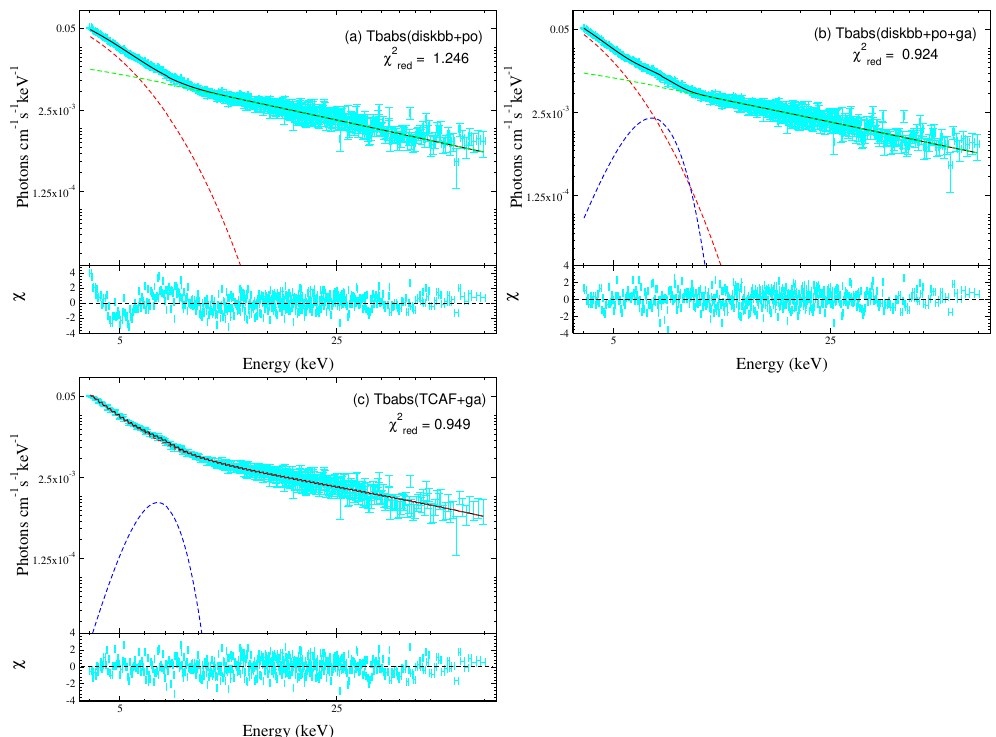
Figure 3. Unfolded spectra using ( a ) Tbabs(diskbb+powerlaw) , ( b ) Tbabs(diskbb+powerlaw+Gaussian) , and ( c ) Tbabs(TCAF+Gaussian) with their ratio. The red, green dashed lines are the blackbody and powerlaw model components. The solid black line refers to the combined best fitted spectra. The blue dashed lines are the Gaussian component.